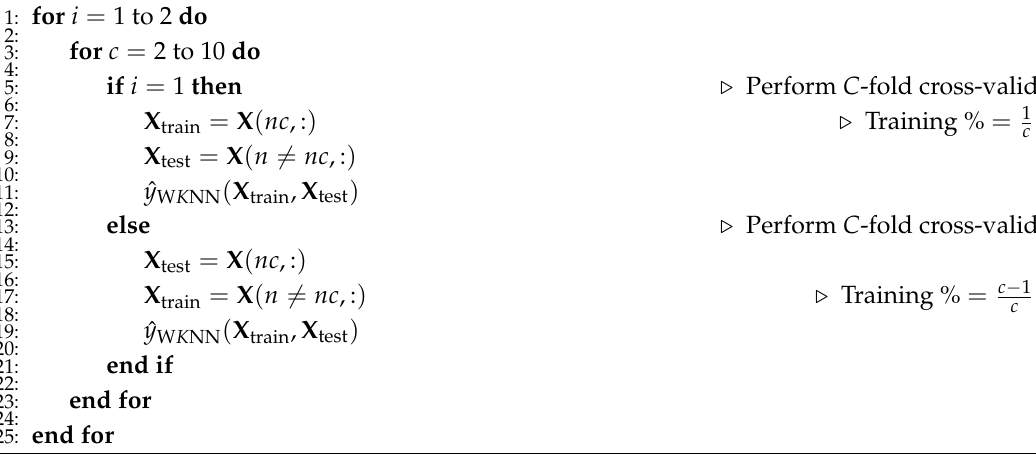
Algorithm 1 Training Percentage and Cross-Validation without Monte Carlo Trials